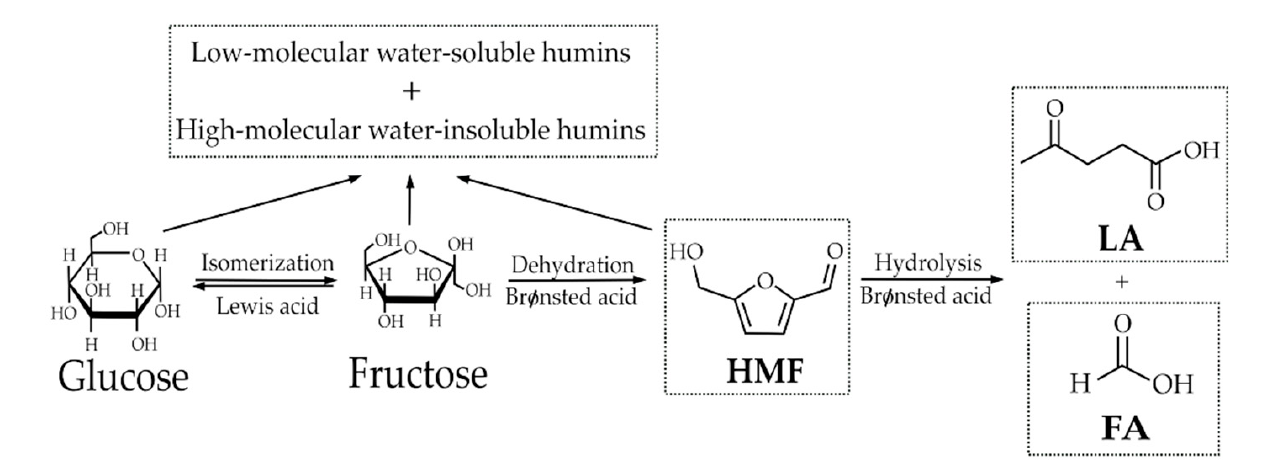
Scheme 1. Reaction pathway of isomerization/dehydration/hydrolysis reactions from glucose to HMF and LA/FA, highlighting the roles of Brønsted/Lewis